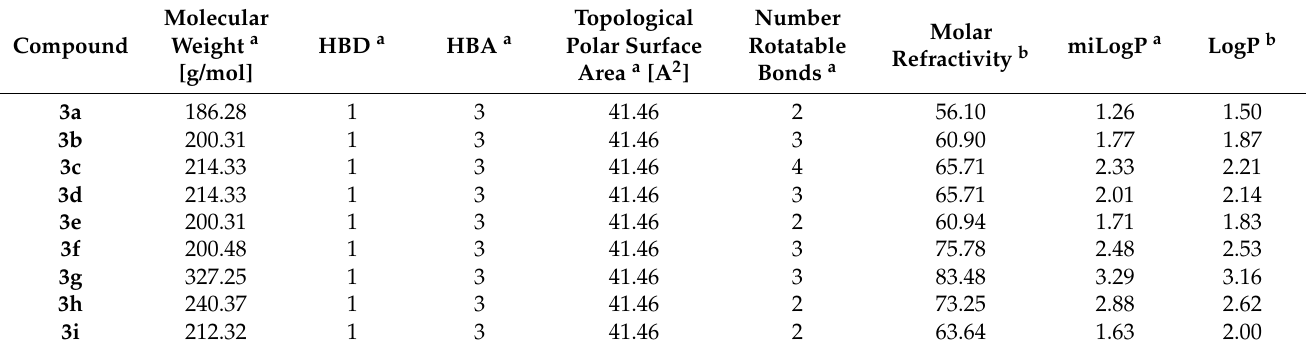
Table 1. Physicochemical properties calculated for compounds 3a – 3i using Molinspiration and SwissADME software.